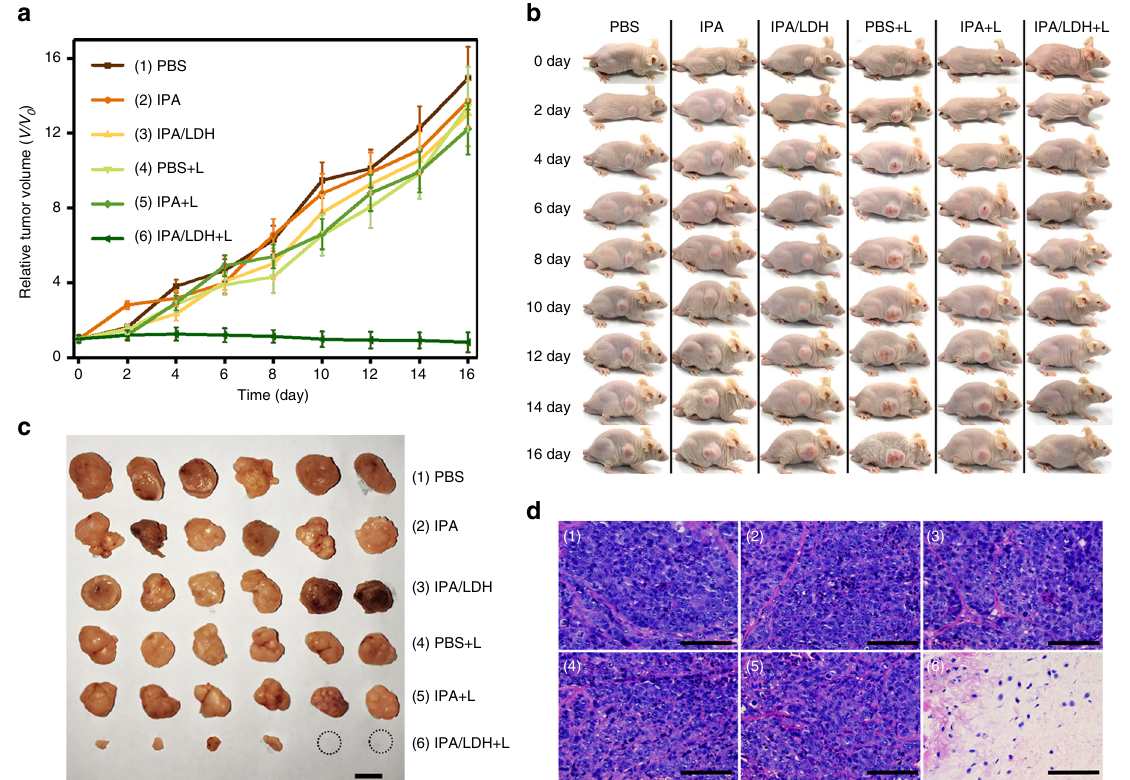
Fig. 6 In vivo PDT effects of IPA/LDH. a Tumor growth curves of mice with the various treatments. Tumor sizes were normalized to their initial sizes ( n = 6 per group). Error bars were de fi ned as standard deviation, n = 6. b Representative photographs of mice with treatments at different days. NIR illumination was carried out for a 10 min exposure using an 808 nm laser at 0.7 W cm − 2 . c Corresponding images of tumors taken on day 16 treatment. Scale bar = 1 cm. d H&E stained tumor tissue slices after 16 d treatments with (1) PBS, (2) IPA, (3) IPA/LDH, (4) PBS with irradiation, (5) IPA with irradiation, (6) IPA/LDH with irradiation. Scale bar = 100 µ